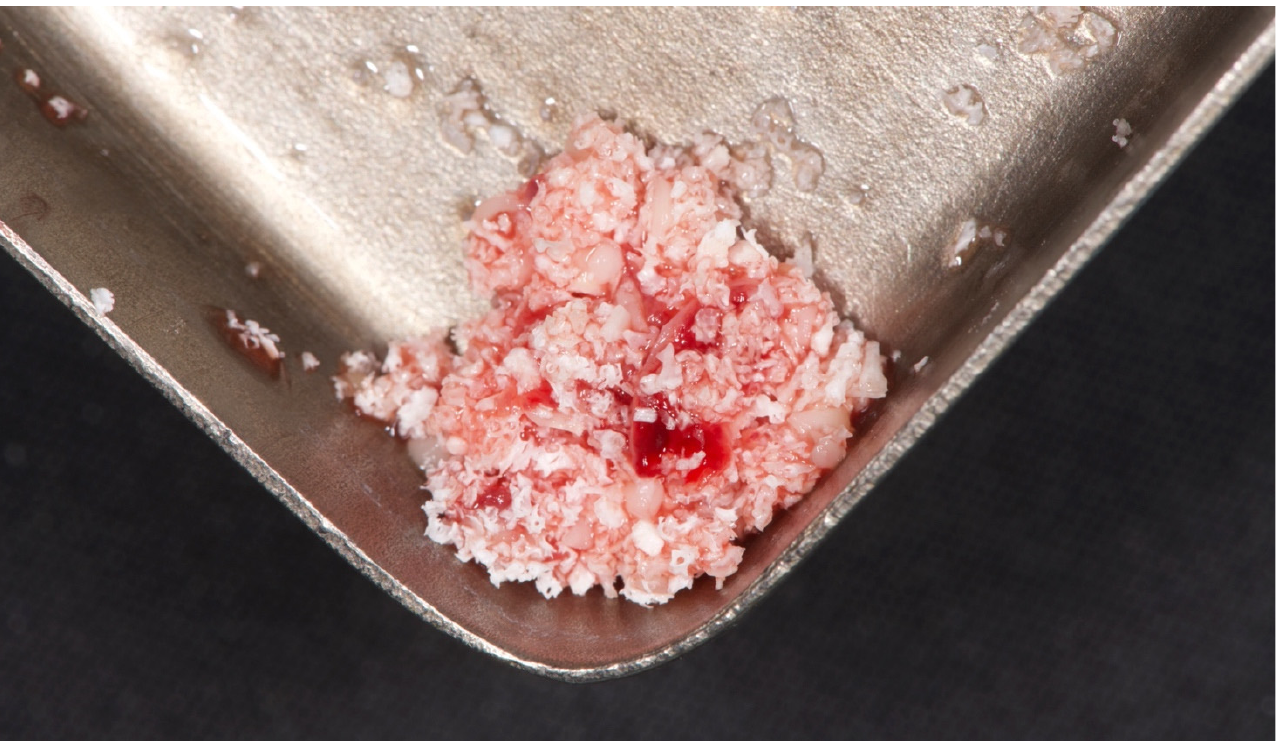
Figure 4. L-PRF mixed with decellularized bovine compact bone from bovine femur.